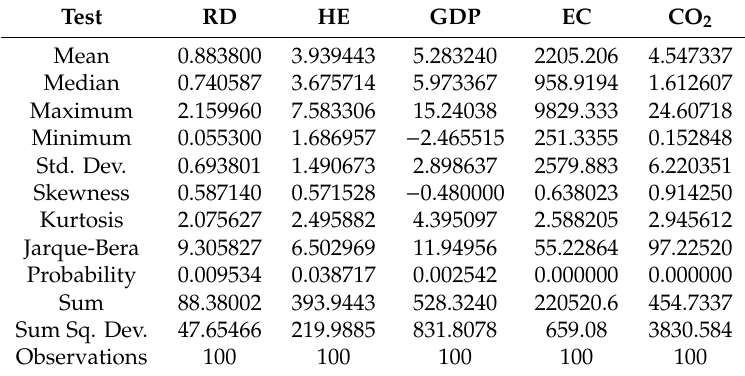
Table 1. Descriptive